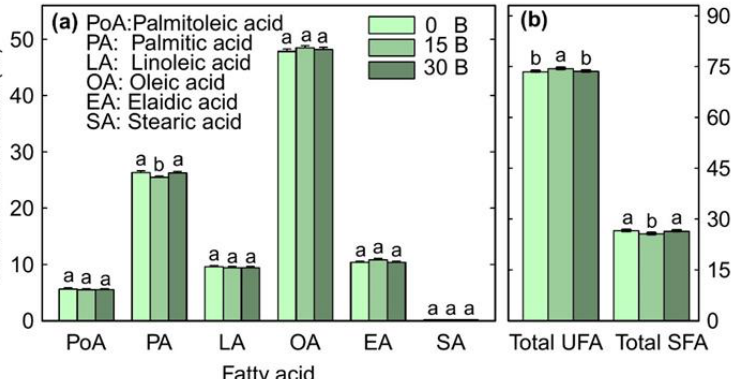
Figure 8. Relative abundances of ( a ) individual fatty acids and ( b ) total unsaturated fatty acids (total UFAs) and total saturated fatty acids (total SFAs) in ripe fruit from Hass avocado trees treated with 0, 15 or 30 g boron (B) per tree prior to anthesis. Means (+SE) with different letters within a fatty acid are significantly different (generalised linear models, p < 0.05, n = 80 fruit).